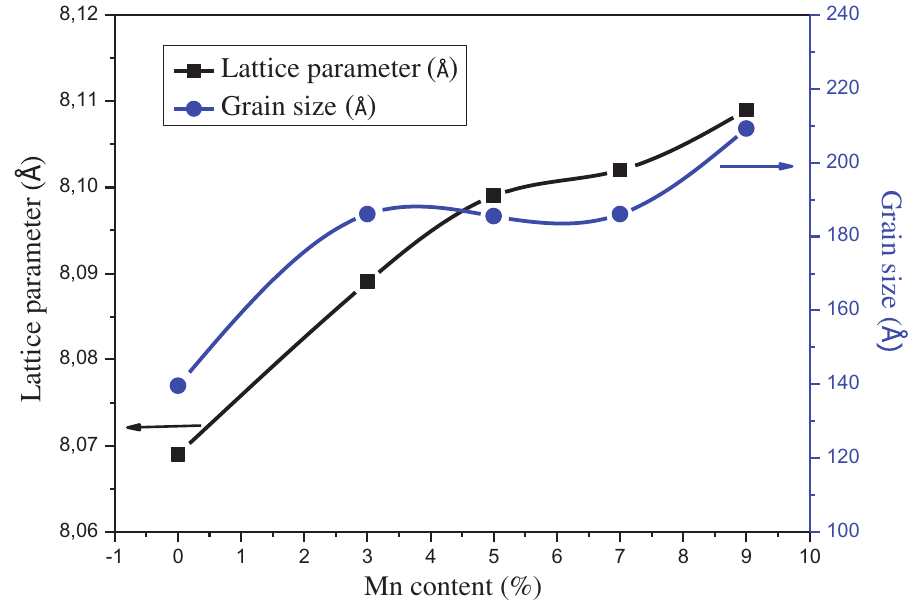
Figure 7: Network parameter and grain size of Mn-doped Co 3 O